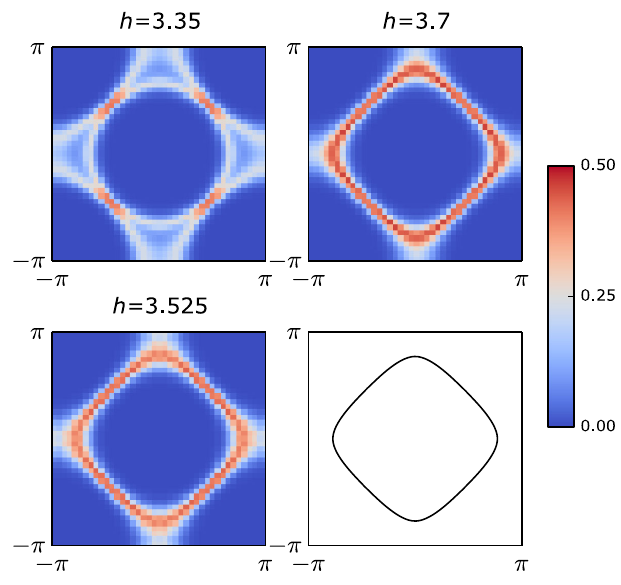
FIG. 2. Fermion Green ’ s function G ð k ; τ ¼ β = 2 Þ as a function of momentum k across the Brillouin zone for three different values of the transverse field: h ¼ 3 . 35 (in the nematic phase), h ¼ 3 . 525 (near the QCP), and h ¼ 3 . 7 (in the disordered phase). In the nematically ordered phase, the data are averaged over both orientations of the order parameter. G ð k ; τ ¼ β = 2 Þ is proportional to the integral of the spectral function A ð k ; ω Þ over an energy window of width T [see Eq. (12)]. The temperature is T ¼ 1 = 8 , and the system size is L ¼ 20 . The data are taken from systems with either periodic or antiperiodic boundary conditions. The Fermi surfaces are seen as peaks in G ð k ; τ ¼ β = 2 Þ . The lower right-hand panel shows the Fermi surface of the bare band